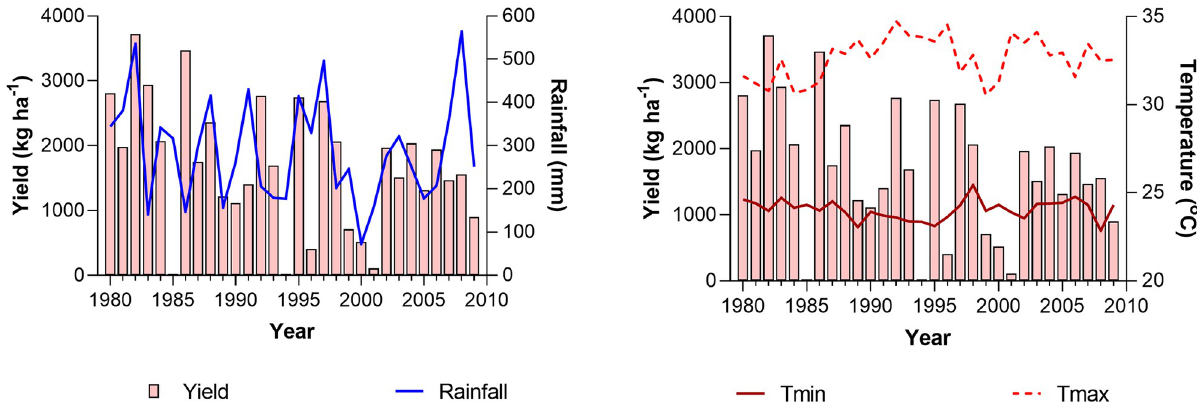
Fig 1. Variation of average simulated Proso millet yield of five accessions and climate parameters during Proso millet growing season in the baseline (1980–2009) period. The Tmin and Tmax stand for seasonally averaged minimum and maximum temperatures respectively.